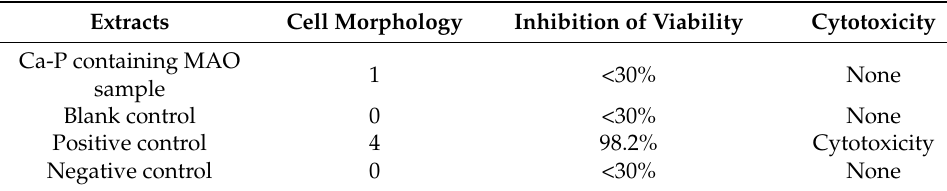
Figure 8. Morphology and confluence of L929 cells after being exposed to ( a ) the Ca-P containing MAO sample, ( b ) blank control, ( c ) positive control, and ( d ) negative control extracts. Table 5. Summary of cytotoxicity test results